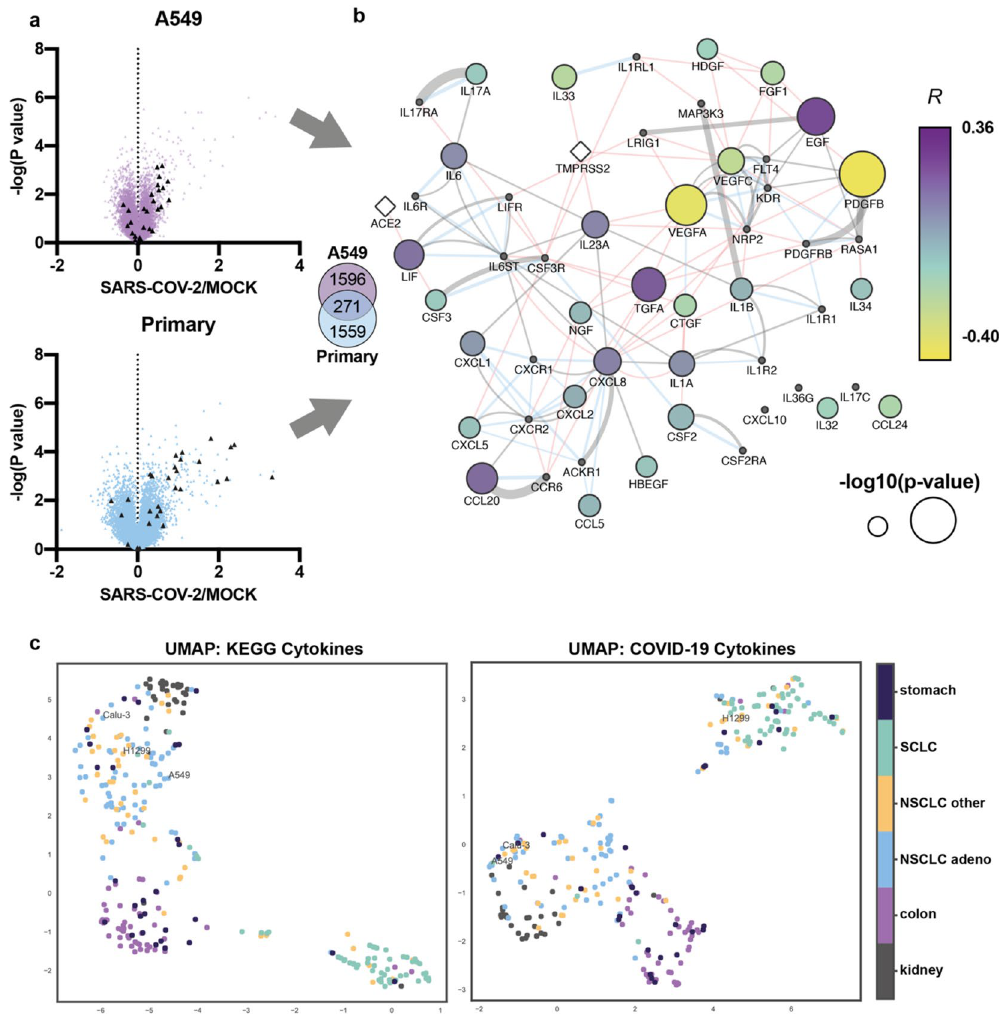
Figure 1. SARS-CoV-2 infection causes changes in the expression of cytokine and growth factors-coding genes that are differently connected with ACE2. ( a ) Volcano plots showing the difference between the expression of genes in A549 and primary lung cells infected with SARS-CoV-2 compared to mock-treated control and the − log(P-value). Each triangle represents a gene. Cyto-DEGs are colored in dark grey. Venn diagram illustrates number of unique A549 and NHBE (primary) DEGs and their intersection (271) ( b ) The network of proteins comprised of cytokine- and growth factors (nodes) created via GeneMania. Black nodes—genes that are added by GeneMania or are absent from GEO: GSE47460 ( CXCL10 , IL36G , IL17c) . Color indicates Spearmen correlation coefficient R between each gene and ACE2 in 108 normal lung samples (purple—max correlation value, R = 0.36 , yellow — max anticorrelation value, R = 0.40 ) , size—− log10 p-value of the calculated correlations. Connections show pathways (grey), genetic interaction (red), and physical interaction (blue). ( c ) UMAP analysis of 65 non-small cell lung cancer (NSCLC) adenocarcinoma, 44 NSCLC of other origins, 59 small cell lung cancer (SCLC), 31 kidney cancer, 50 colon cancer, and 28 stomach cancer cell lines from Sanger dataset. UMAP was performed using cytokine-cytokine receptor interaction pathway (KEGG) and COVID-19 cytokines gene